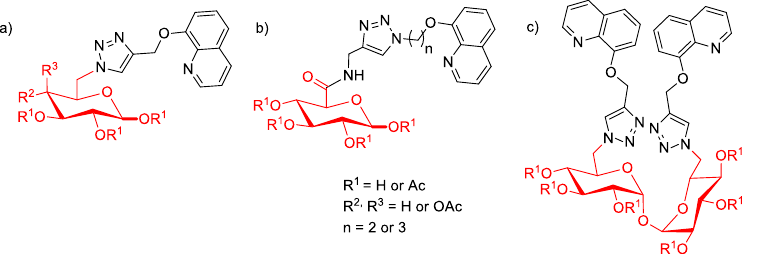
Figure 10. 8-Hydroxyquinoline glycoconjugates containing sugar functionalized at C-6 position ( a – c